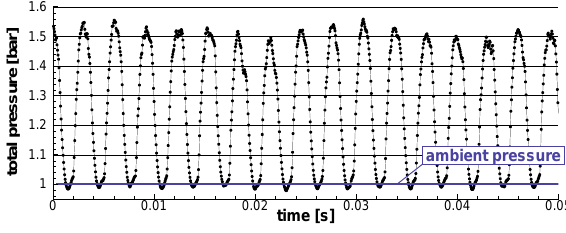
Figure 3. Time history of total pressure data for one outlet of Segment S1.